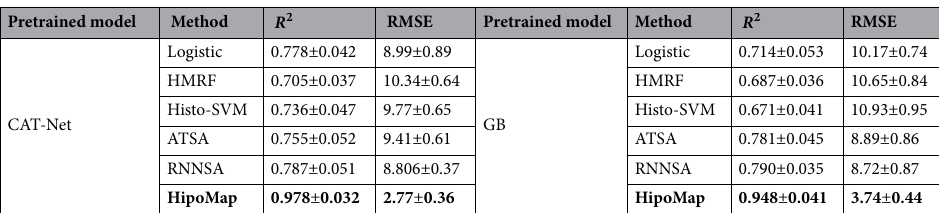
Table 6. Slide-based performance of survival prediction with HipoMap and the benchmark methods. The best performance is highlighted in bold.